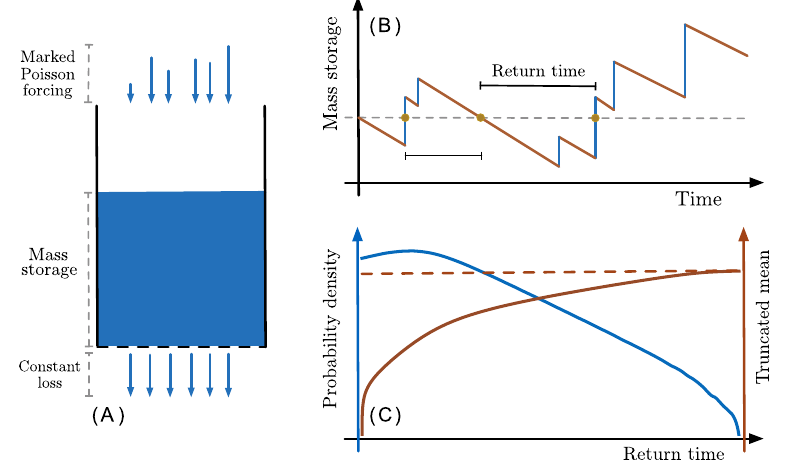
Figure 1. (A) Conceptual illustration of our mass balance model. (B) Illustration of the behavior of a typical trajectory for a realization of the model. Returns to a reference level (dashed horizontal line) are marked with full circles. (C) Typical return time probability density corresponding to a given trajectory, the mean of this density truncated to a given return time, and the full density’s mean (dashed horizontal line). The truncated mean eventually converges to the full distribution’s mean, but may differ significantly depending on the scale of